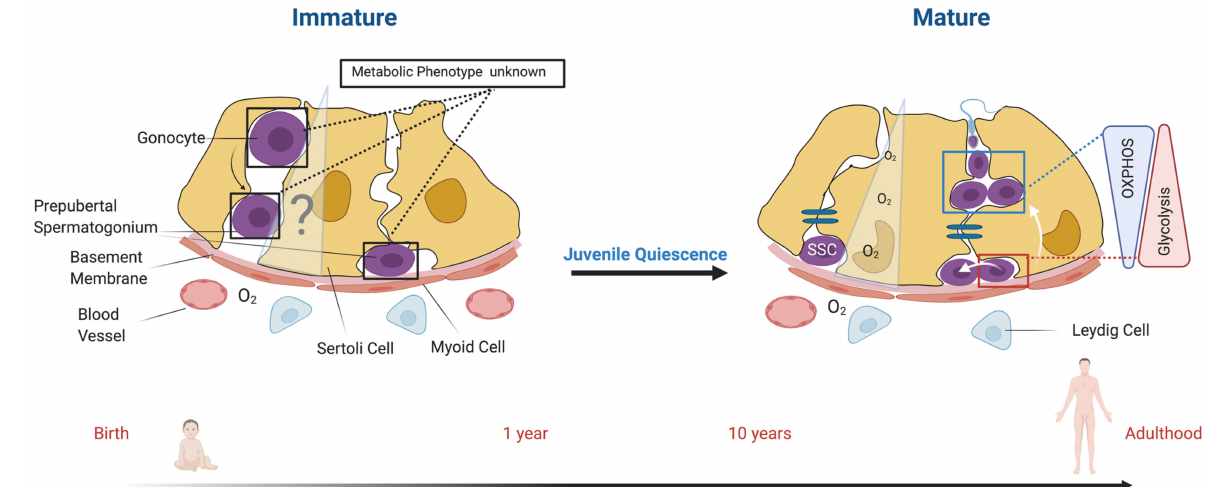
Figure 1. Schematic representation of the migration process and metabolic phenotype of human male germ cells during maturation (immature) and differentiation (mature). Immature (left; from birth to roughly 1 year in humans): Germ cells occupy distinct positions during immature spermatogonial development within the seminiferous epithelium. Gono- cytes/prospermatogonia move from the center of the seminiferous cord to the basement membrane through a loose Sertoli cell scaffold. Metabolism of gonocytes/prospermatogonia and prepubertal spermatogonia, nutrient, and oxygen distribution in the immature seminiferous epithelium are unknown (question mark). Migrated spermatogonia reside in juvenile quiescence for over a decade before puberty. Mature (right; from puberty to adulthood): the Sertoli cells are mature and the seminiferous epithelium is compartmentalized by the Sertoli cell barrier as part of the blood testis barrier (blue). Within the adult testis, spermatogonial stem cells (SSCs) remain quiescent (single SSC), self-renew (white arrow at the basement membrane), or differentiate by migrating up to the adluminal compartment of the seminiferous epithelium (white arrow pointing up). SSCs rely on an anaerobic metabolism and switch toward oxidative phosphorylation (OXPHOS) with differentiation. The oxygen pressure decreases with diffusion through the epithelium. Elongated spermatid and sperm metabolism are highly complex and characterized by differences in metabolism between head and tail and therefore excluded from this simplified schematic (figure created with